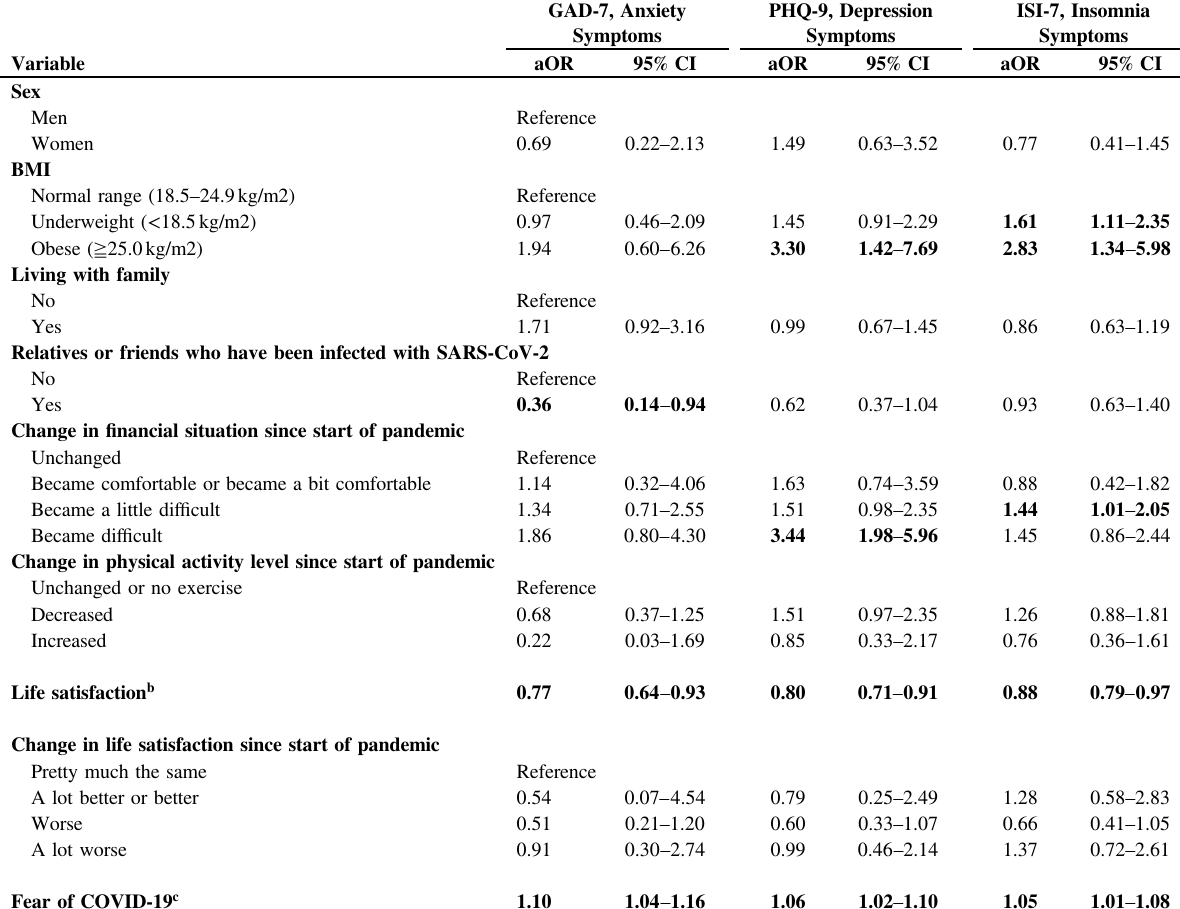
Table 4 Risk Factors for Anxiety, Depression, and Insomnia Symptoms by Multivariable Logistic Regression Analysis